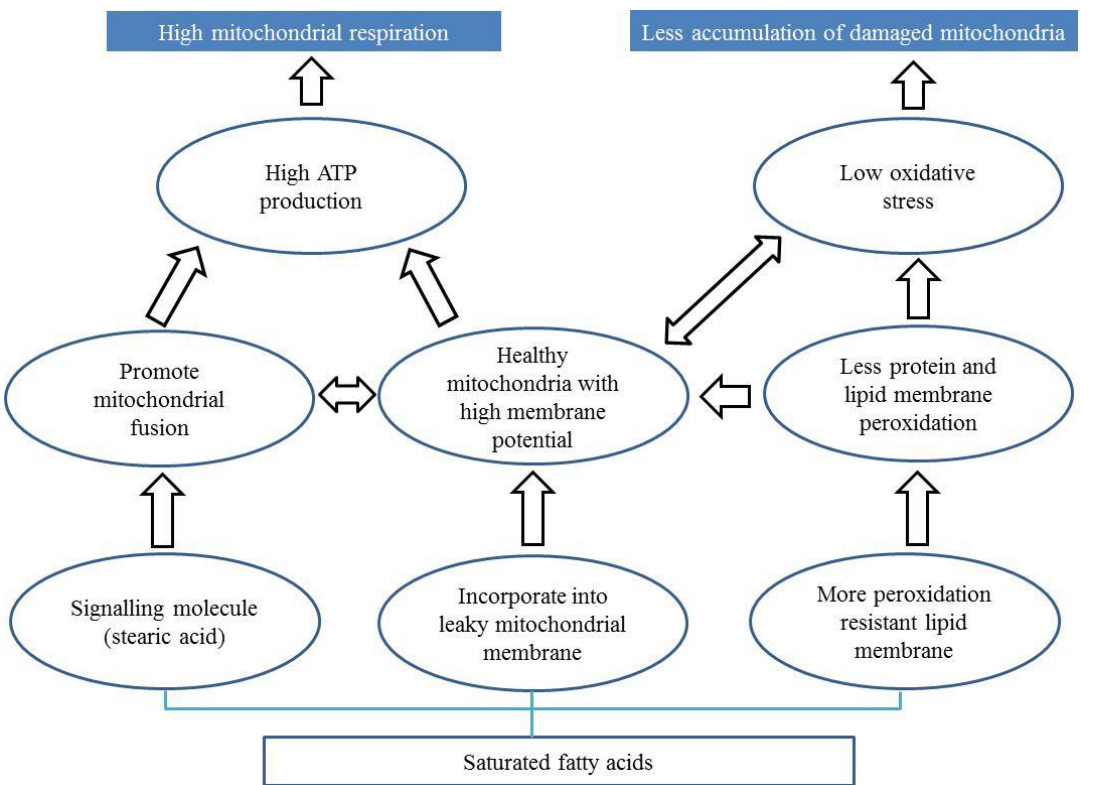
Figure 2. Potential mechanisms by which fatty acid can prevent mitochondrial dysfunction in PD. Fatty acid can be involved in mitochondrial function in three possible ways. First, fatty acid (stearic acid) can act as a signalling molecule to promote mitochondrial fusion. Second, saturated fatty acids can be directly incorporated into leaky mitochondrial membranes. Third, saturated fatty acids can be incorporated into lipid membranes making them resistant to peroxidation. The bottom rectangle is the macronutrient (saturated fatty acid). The ovals represent the potential mechanisms and processes of how the macronutrient can affect mitochondrial functions. The top blue filled rectangles are the ways that can lead to healthy and efficient mitochondria in PD.